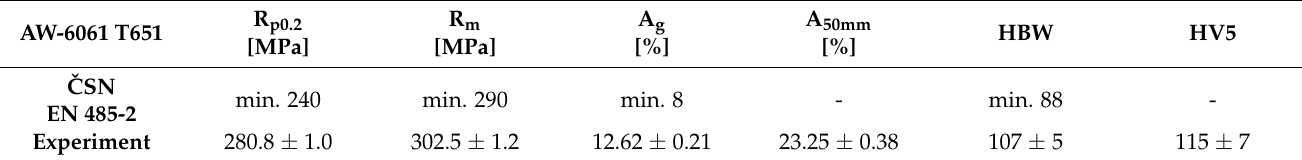
Table 2. Mechanical properties of alloy AW